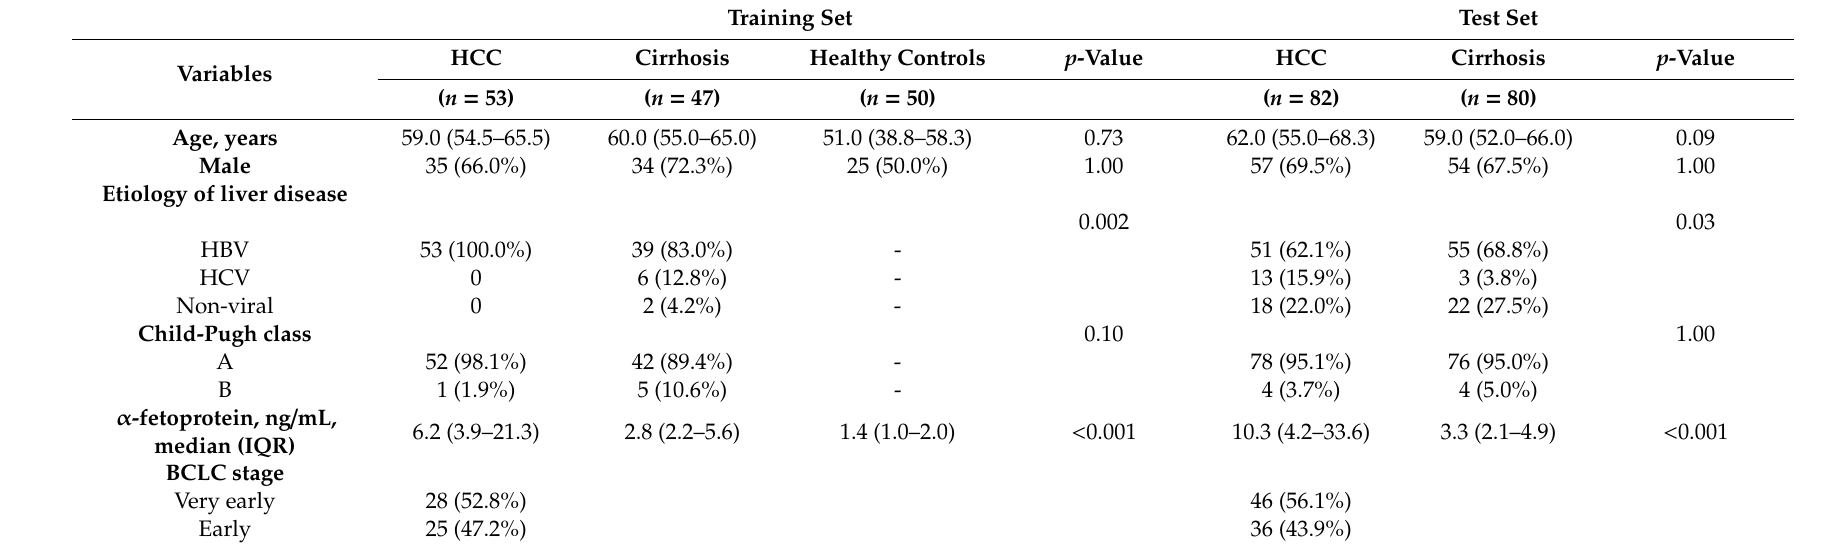
Table 1. Clinical characteristics of the subjects in each